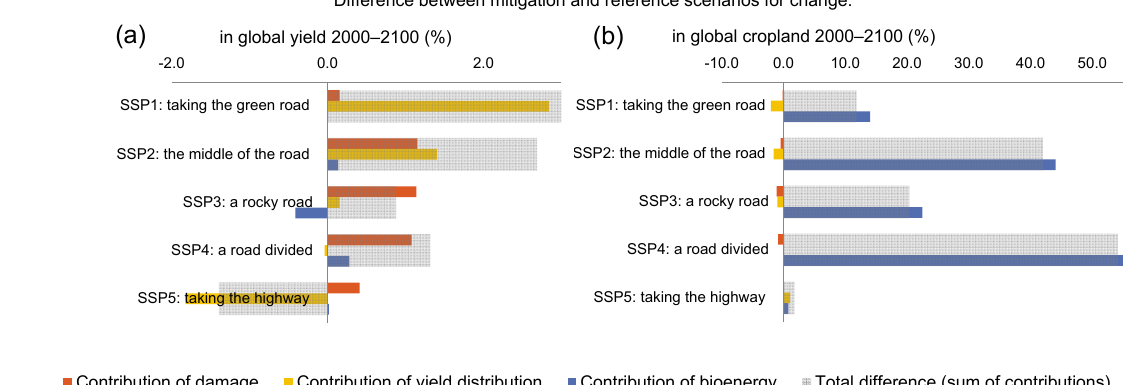
Figure 6. (a) Difference between reference and mitigation scenarios for change in global yield between 2000 and 2100 (%) and (b) change in global cropland area between 2000 and 2100 (%). The grey bar gives the total differences (sum of differences due to damage, yield distribution and bioenergy), while the coloured bars show the contribution of each causal factor to the total